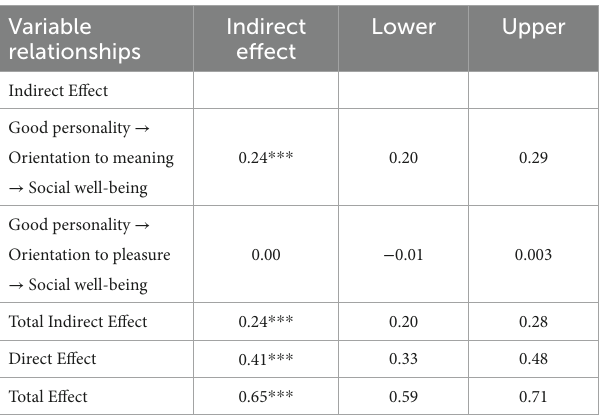
TABLE 3 Analyses of indirect effects of